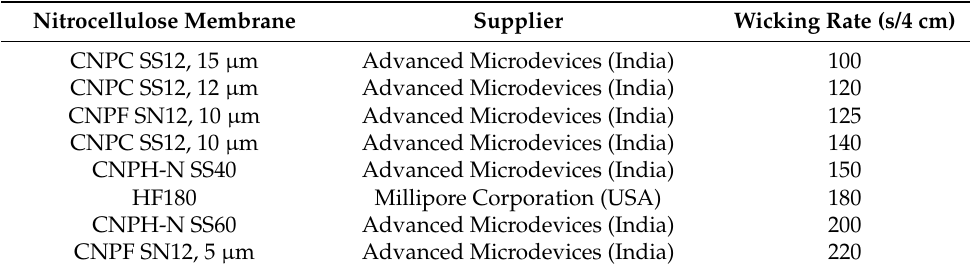
Table 2. Nitrocellulose membranes studied in the